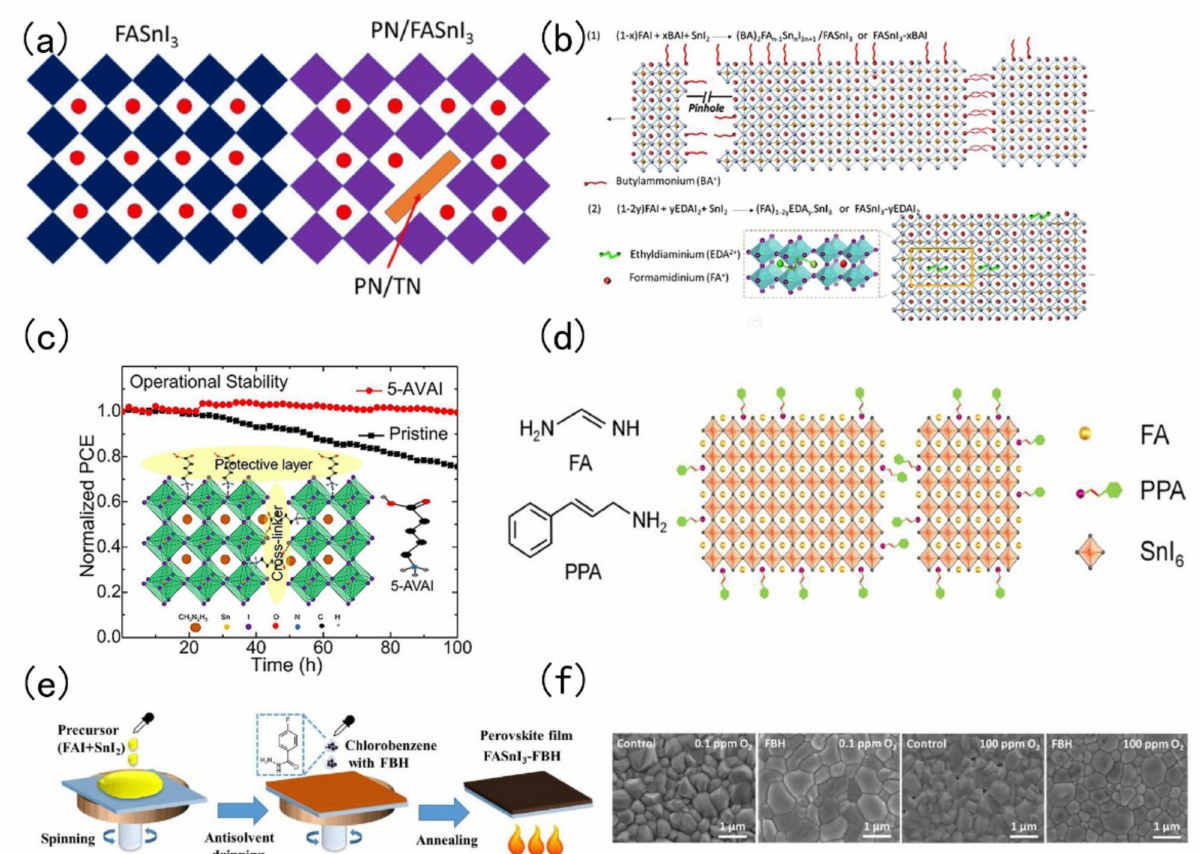
Figure 2. ( a ) Internal structure of PN/TN acting on perovskite). Reproduced with permission from [38]. Copyright 2016 American Chemical Society. ( b ) Internal structure of BA + /EDA + acting on perovskite. Reproduced with permission from [44]. Copyright 2018 The Royal Society of Chemistry. ( c ) The stability of the device with 5-AVAI modification over time and the stability of the device without 5-AVAI modification with time (inside is the diagram of the internal structure of 5-AVAI acting on perovskite). Reproduced with permission from [45]. Copyright 2019 American Chemical Society. ( d ) The chemical structure formula of FA/PPA and the internal structure of PPA acting on perovskite. Reproduced with permission from [46]. Copyright 2019 Elsevier Inc. ( e ) Flow chart of FBH modified perovskite films. Reproduced with permission from [48] Copyright 2020 The Royal Society of Chemistry. ( f ) Scanning electron microscopy image of